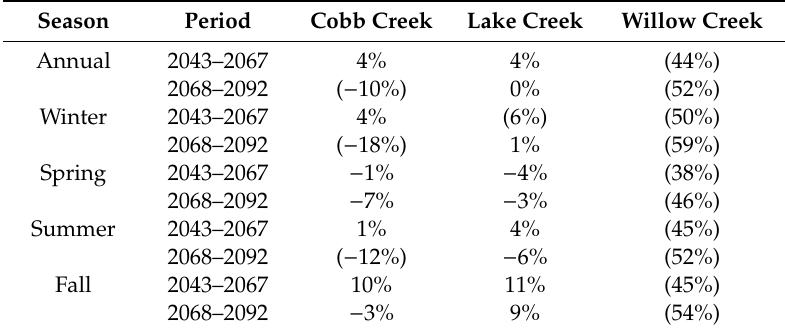
Table 1. Changes in mean seasonal streamflow at the Cobb, Lake, and Willow Creek before (2018–2042) and after (2043–2067 and 2067–2092) the implementation of land management scenarios under projected climate. Significant changes are shown in